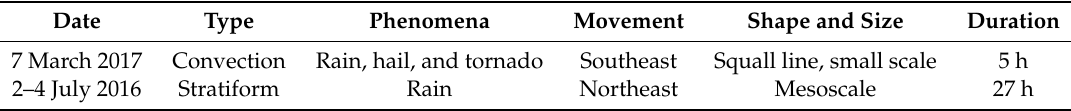
Table 1. Summary of two events for attenuation correction and rain rate estimation. Type Phenomena Movement Shape and Size Convection Rain, hail, and tornado